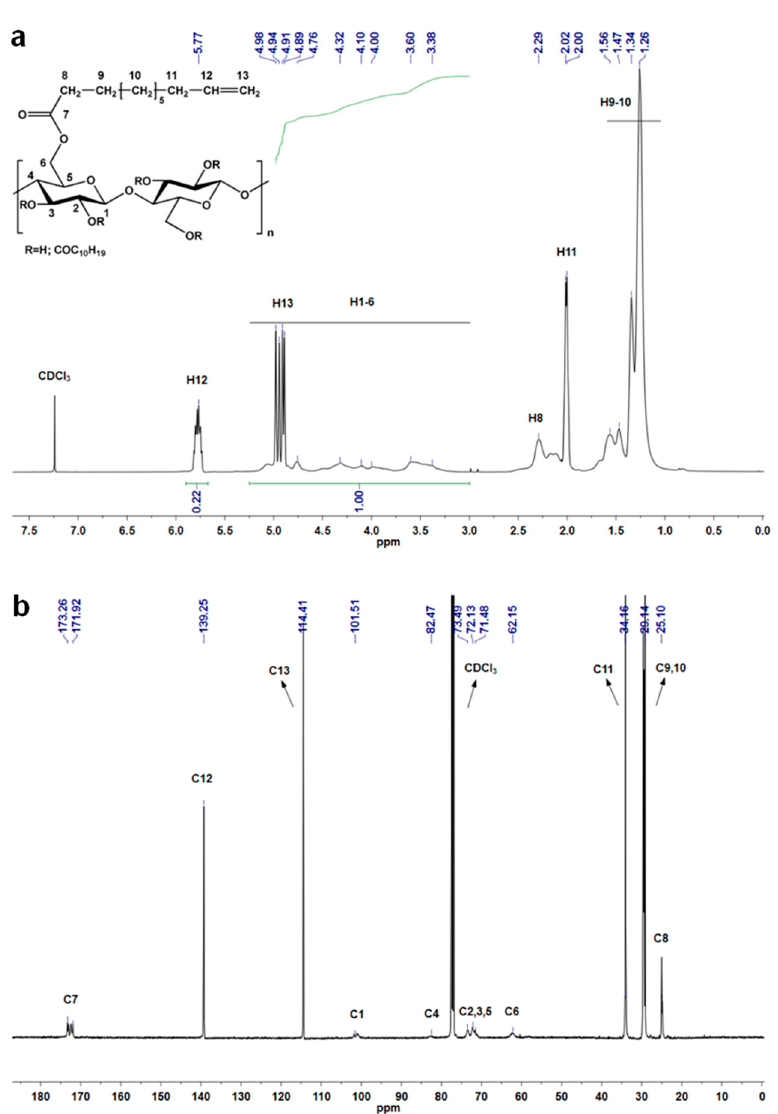
Figure 1. ( a ) 1 H and ( b ) 13 C NMR spectra of CUE (CDCl 3 as solvent) with inserted molecular structure of CUE.